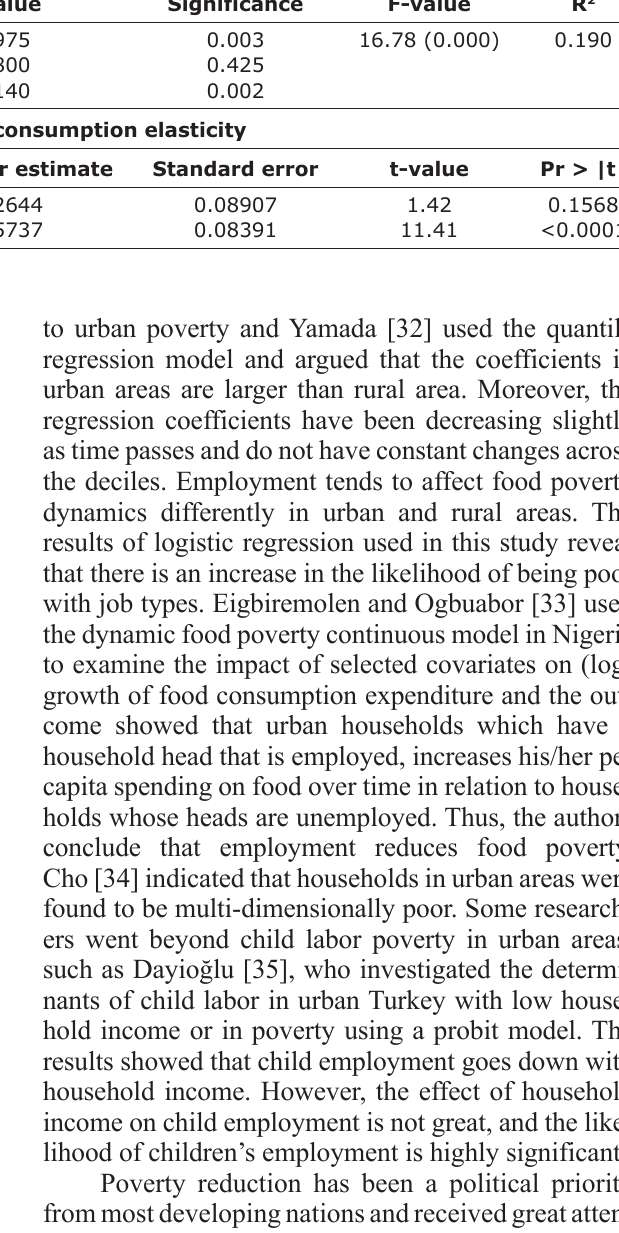
Table-5: Influence of small ruminants on the total kilocalories consumption.